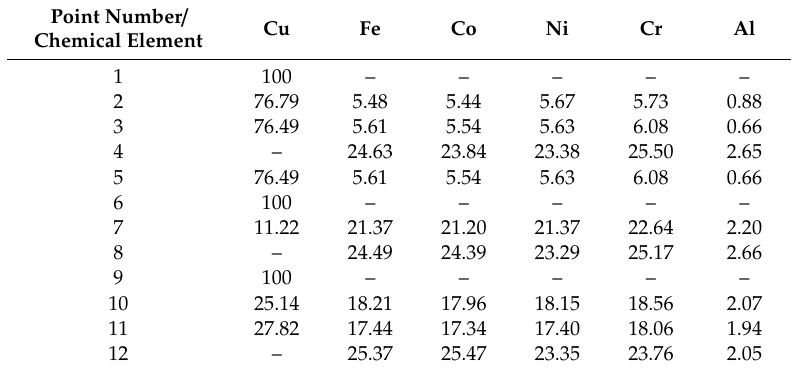
Table 4. Chemical composition of corresponding points for nanoindentation image (Figure 11)